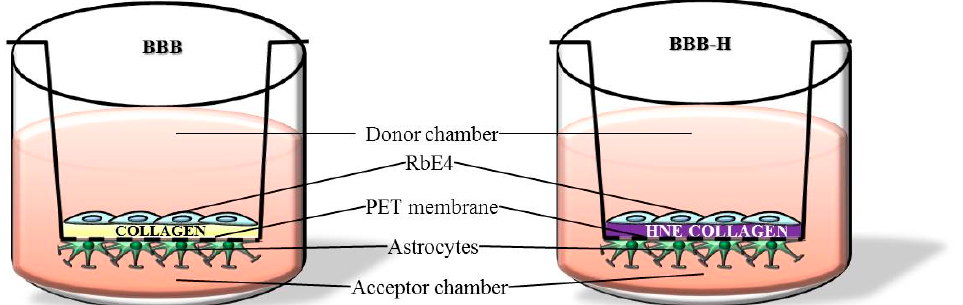
Figure A2. Schematic representation of BBB and BBB-H models.